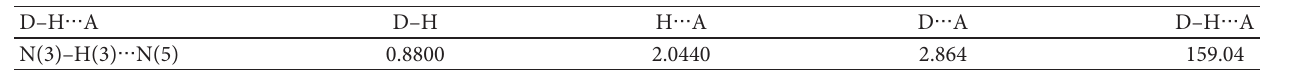
Figure 1: (a) The structure of ligand L2. (b) Molecular accumulation figure viewed along a-axis in L2 (green lines represent the H-bonds). Table 4: Hydrogen bonds for the L2 (˚A and ° ).